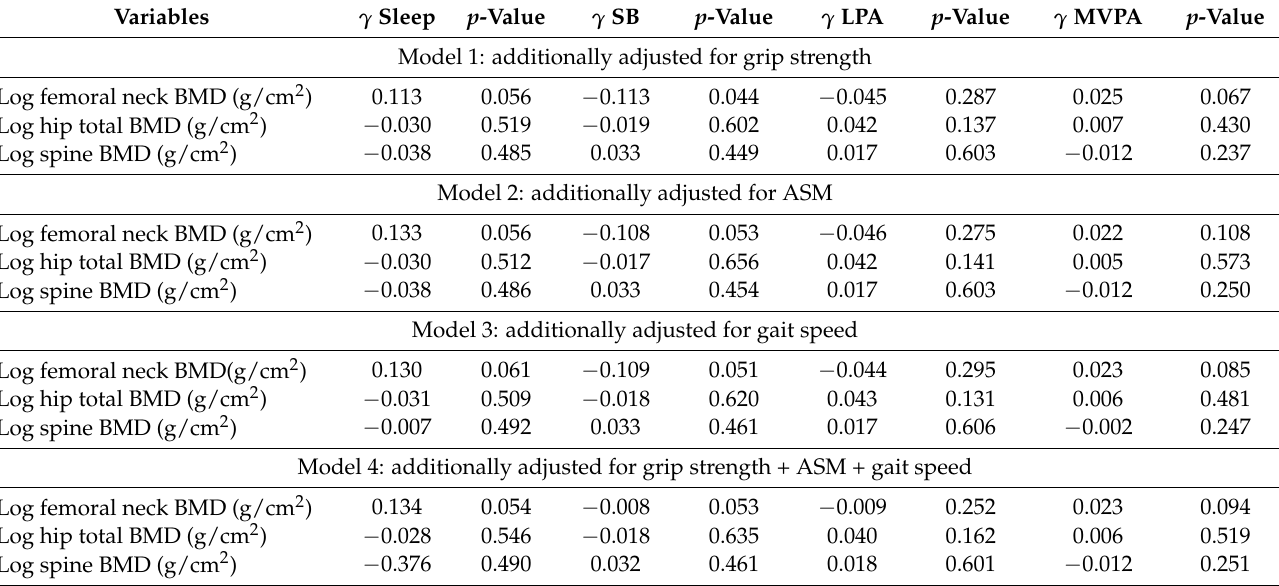
Table 5. Compositional linear regression model for Scottish cohort between bone mineral density variables and movement behaviors considering bone-muscle